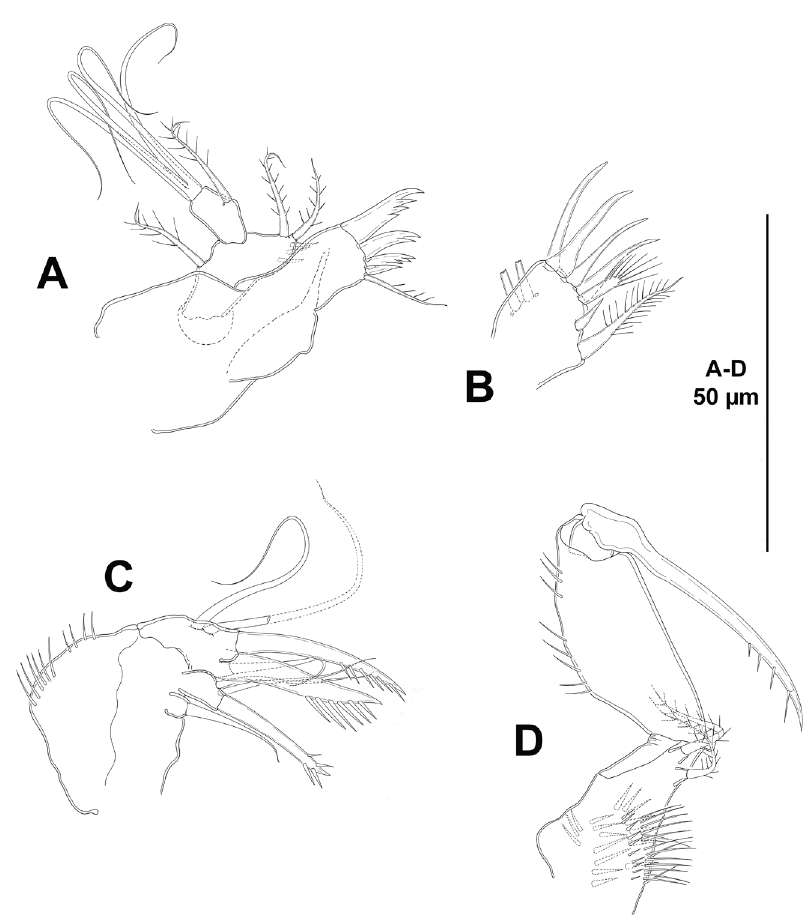
Figure 12. Odiliacletodes secundus sp. n., female holotype. A mandible B arthrite of praecoxa of the maxillule C maxilla D